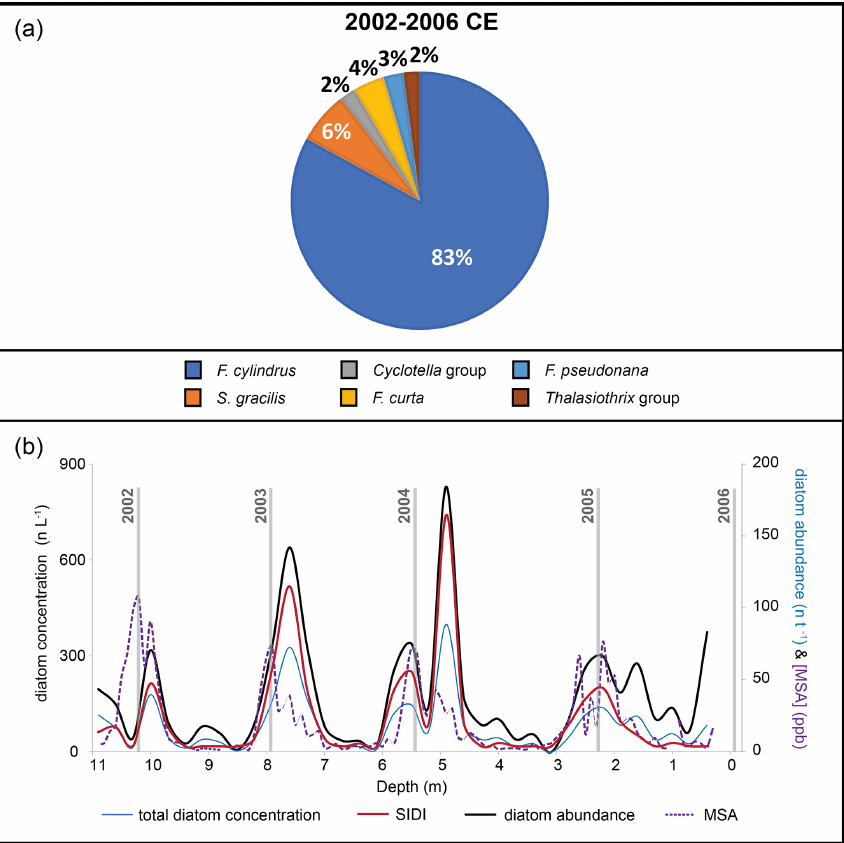
Figure 5. Diatom record from the ROIC ice core. (a) Main diatom assemblage composition of the ROIC ice core (2002–2006CE). Percent- ages reported in this figure were normalized to the main species identified. (b) Total diatom concentration, total diatom abundance, and SIDI variations down-core for the 2002–2006CE horizon. Vertical grey lines indicate temporal horizons based on the austral summer maxima in